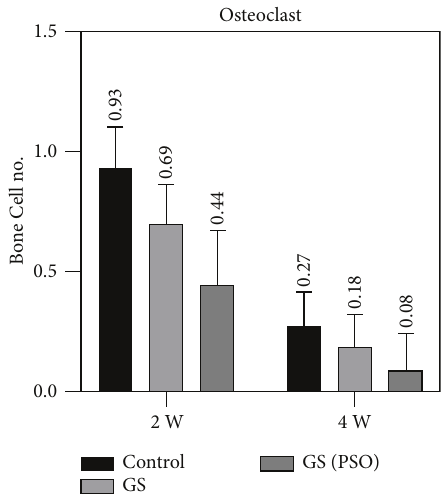
Figure 10: A bar chart representation of the mean and standard deviation of bone cells after 2- and 4-week time intervals, con- sidering TA.